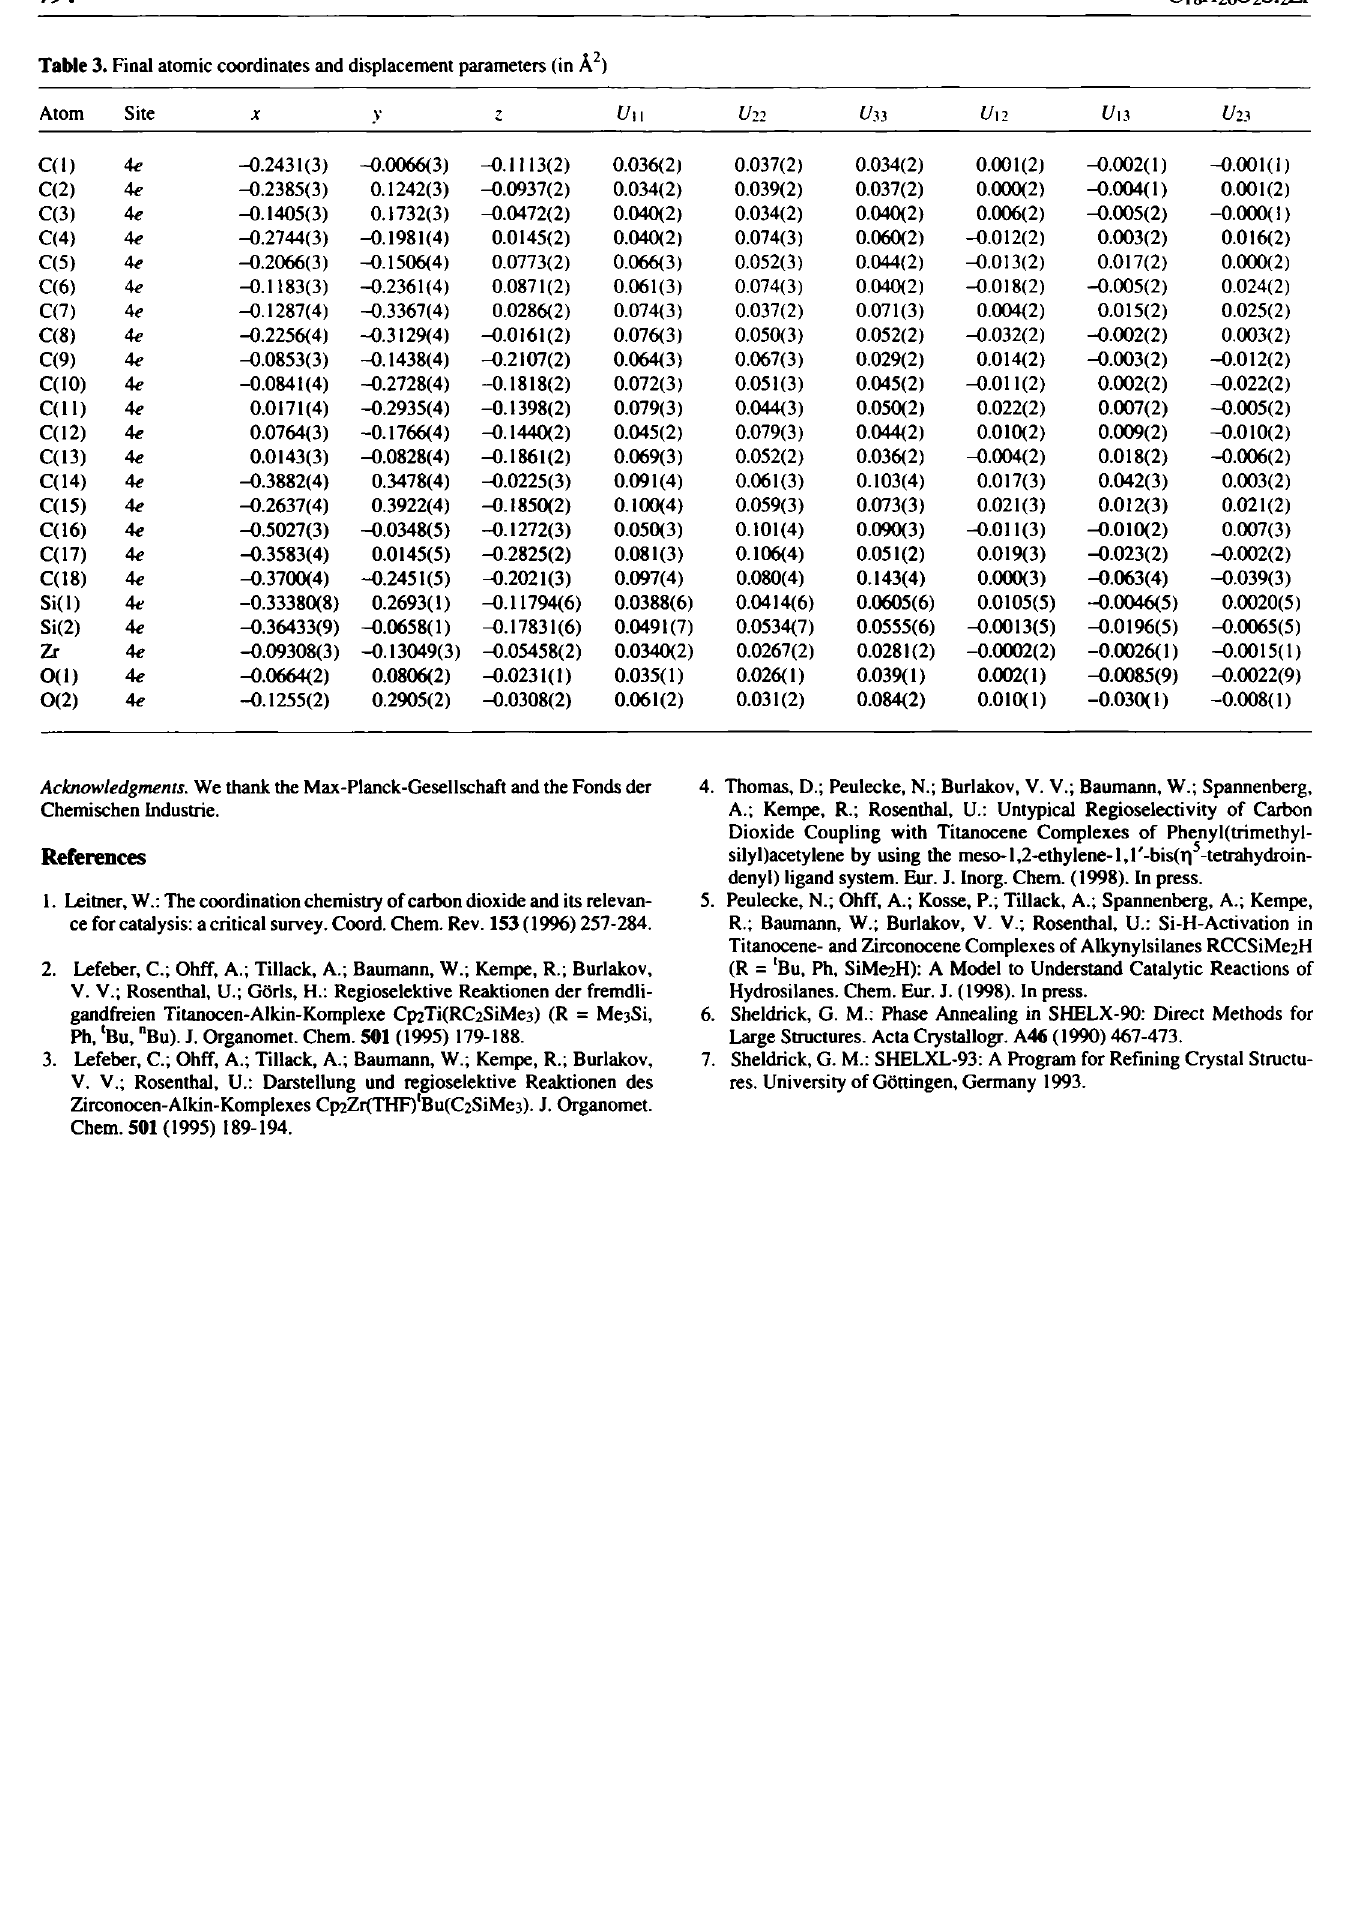
Table 3. Final atomic coordinates and displacement parameters (in